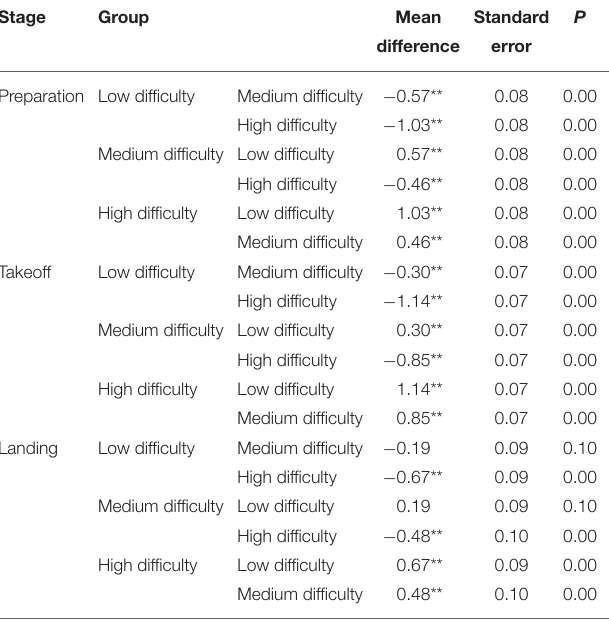
TABLE 9 | Post-hoc comparison of variance analysis of experts’ performance at different stages in tasks with different difficulty levels. Stage Group Mean